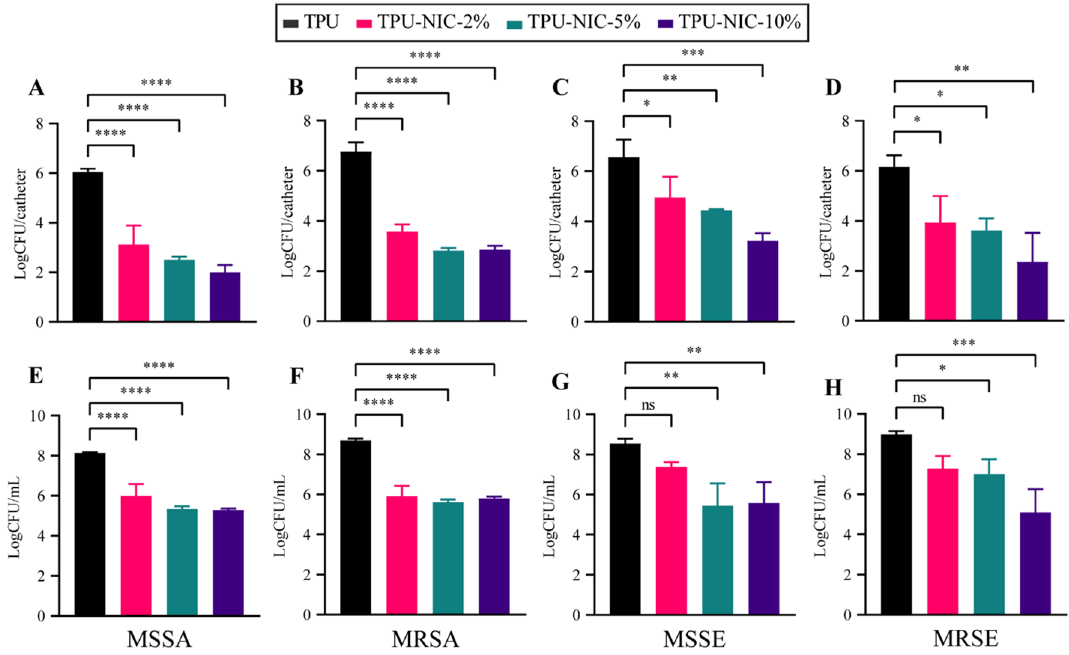
Figure 6. In vitro activity of NIC-loaded catheters against biofilm formation and planktonic growth in the surrounding medium after inoculation with 5 × 10 6 CFU of different S. aureus and S. epidermidis strains. Top row: biofilm growth (24 h) on catheters segments and bottom row: Planktonic bacterial growth in surrounding media (24 h) of ( A , E ) MSSA; ( B , F ) MRSA; ( C , G ) MSSE and ( D , H ) MRSE. Each group was analyzed in triplicate and data expressed as mean LogCFU with SD. *Indicates a p -value of 0.01 to 0.05, **indicates a p -value of 0.001 to 0.01, *** p -value of 0.0001 to 0.001, ****indicates a p value < 0.0001, ns indicates a non-significant p